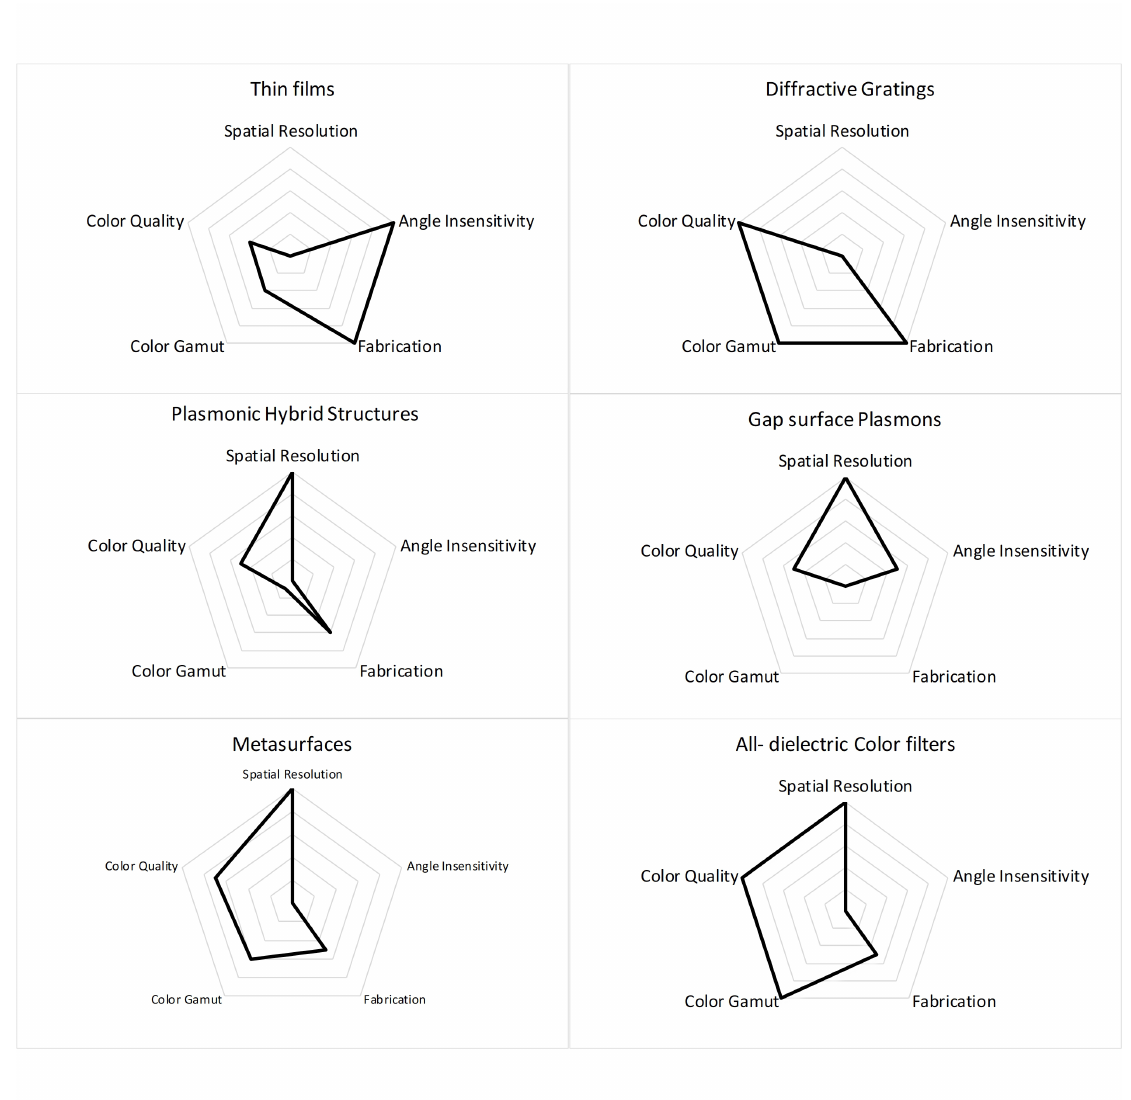
Figure 11. Key Performance Indicator charts for nanostructure color